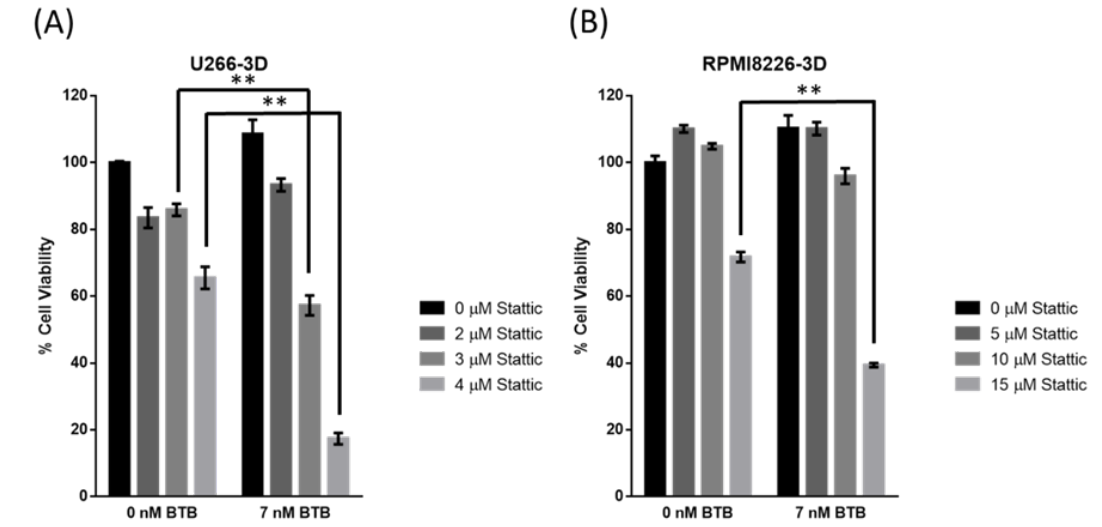
Figure 5. STAT3 inhibition in MM-3D cells sensitizes them to bortezomib. Cell viability of ( A ) U266- and ( B ) RPMI8226-3D cells was measured after treatment with Stattic, bortezomib (BTB) or both for 48 h. U266 and RPMI8226 were pre-cultured in 3D for 2 days and 1 day before drug treatment to reach a substantial pSTAT3 level, respectively. Cell viability was measured by MTS assay and normalized to the cell viability of untreated cells. 2.5 × 10 5 cells were seeded initially. The error bars represent